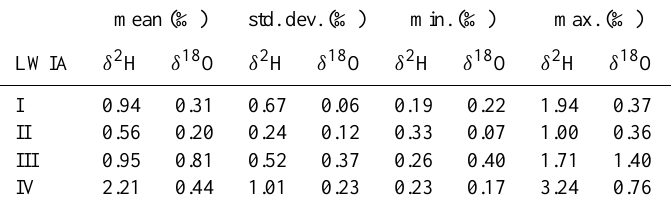
Table 6. Basic descriptive statistics of the maximum difference between repeated δ 2 H and δ 18 O measurements. mean (‰) std. dev. (‰) min. (‰) max. (‰) LWIA δ 2 H δ 18 O δ 2 H δ 18 O δ 2 H δ 18 O δ 2 H δ 18 O I 0.94 0.31